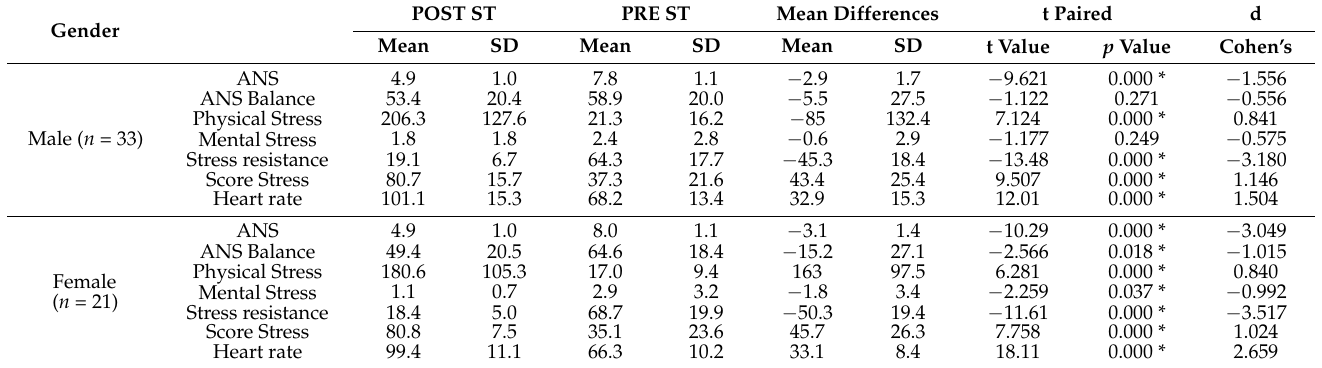
Table 4. Comparison, separated by gender, of differences in scores between after and before the